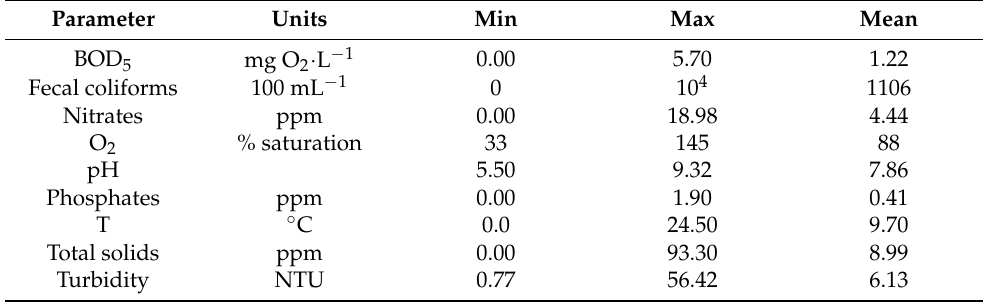
Table 1. Descriptive statistics of the limnological parameters measured in sampling